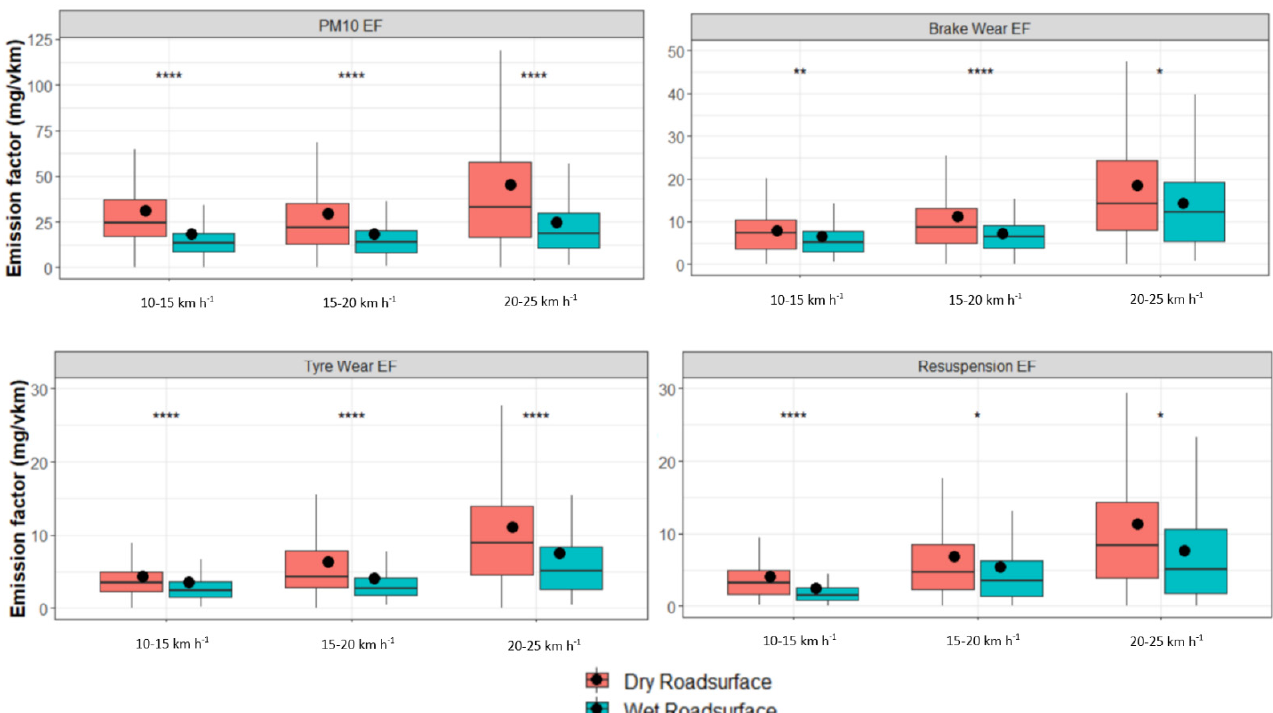
Figure 6. Average vehicle fleet emission factors of PM 10 , brake wear, tyre wear, and resuspension by road surface wetness and measured vehicle speed (5 km h − 1 bins). The interquartile (box plot extents), median (central black line), and mean (black dot) emission factors are shown, and the Wilcoxon signed-rank test p -value symbols are displayed by the asterisks above (* = P ≤ 0.05, ** = P ≤ 0.01, *** = P ≤ 0.001, **** = P ≤ 0.0001).